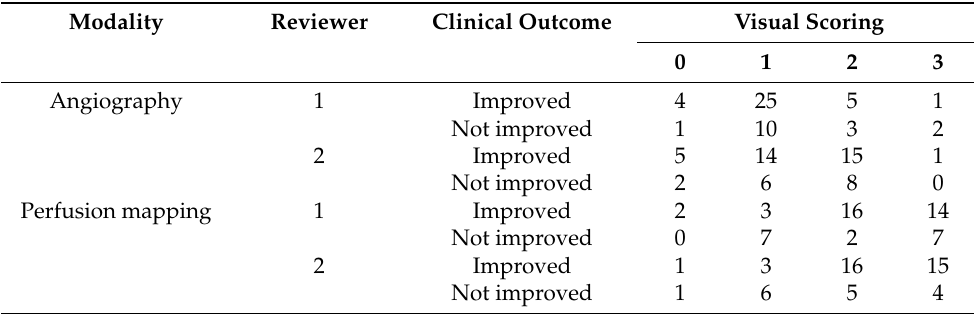
Table 2. Correlations between clinical outcome evaluation with visual scoring by imaging modalities after percutaneous transluminal angioplasty and clinical